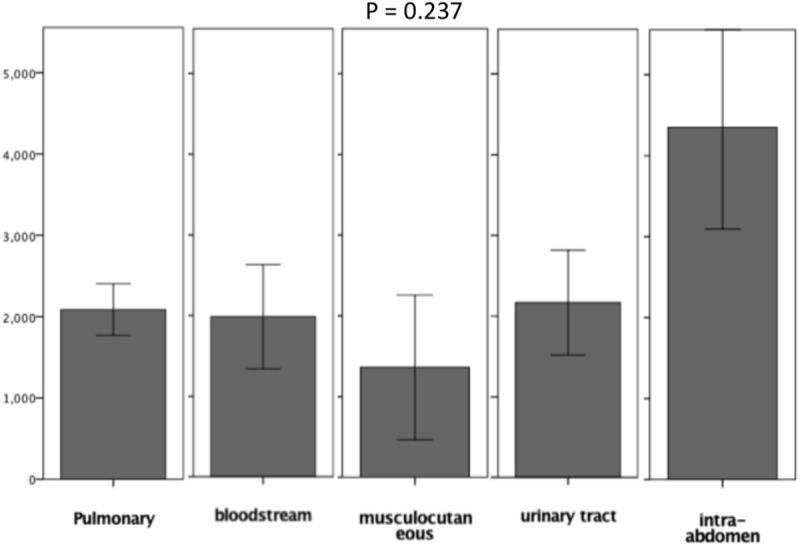
72-hr cumulative fluid balance (CFB) between patients with infections of various origin.Similar 72-hr CFB values were observed in patients with sepsis originating from intra-abdominal infection (4939.4±1256.7 ml), urinary tract infection (2167.4±648.2 ml), pulmonary infection (2086.3±317.3 ml), bloodstream infection (1986.8±645.1ml), and soft tissue infection (1360.9±895.8ml) (p = 0.273 using ANOVA).